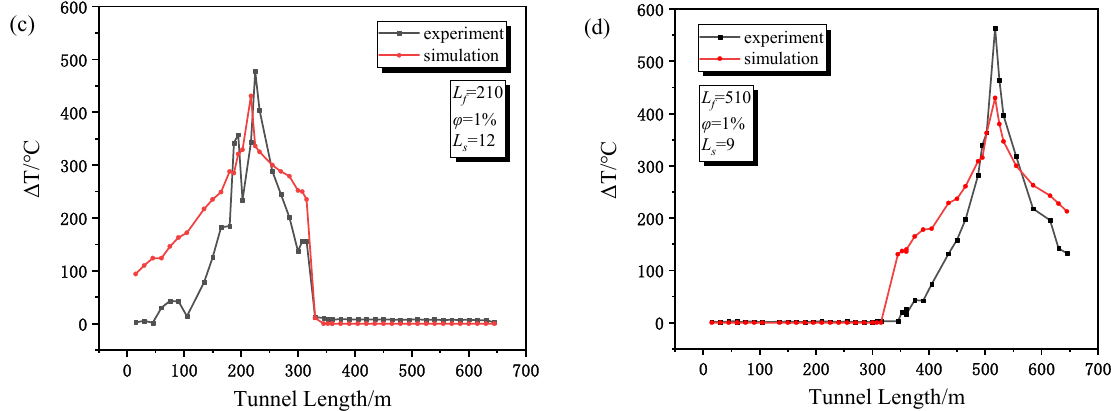
Figure 5. Comparison of experimental and numerical maximum ceiling temperature rise. ( a ) L f = 390, ϕ = 1%, L s = 9 ( b ) L f = 390, ϕ = 1%, L s = 12 ( c ) L f = 210, ϕ = 1%, L s = 12 ( d ) L f = 210, ϕ = 1%, L s = 9.